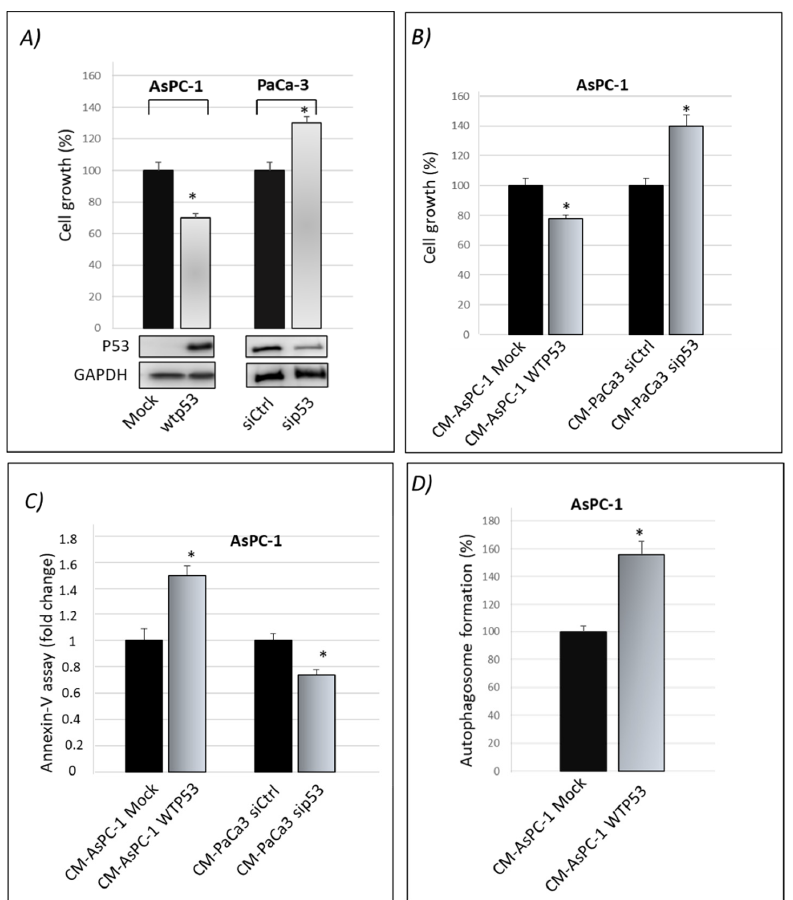
Figure 1. Cancer cell secretome driven by wild-type p53 exhibits oncosuppressor roles. ( A ) Cell growth was measured by Cristal Violet assay in p53-null AsPC-1 cells transfected for overexpression of wtp53 and in PaCa3 after knocking-down of endogenous p53 to verify the transfection efficiency. Accompanying Western blotting of p53 and of GAPDH for control loading are reported. Statistical analysis * p < 0.05 wtp53 vs. Mock AsPC-1; sip53 vs. siCtrl PaCa3 . ( B ) Cell